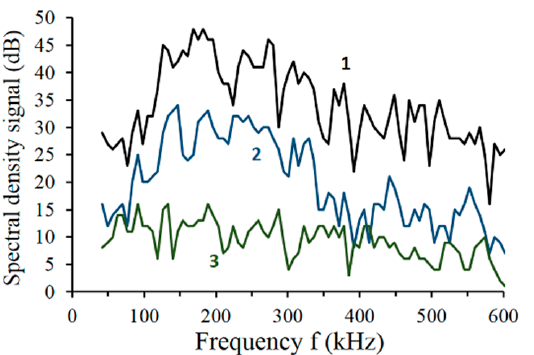
Figure 10. Spectral characteristics for bearing steel indicating energies of event patterns used in artificial neural networks (ANNs): 1—high energy AE events, 2—medium energy AE events, and 3—low energy AE events of background.